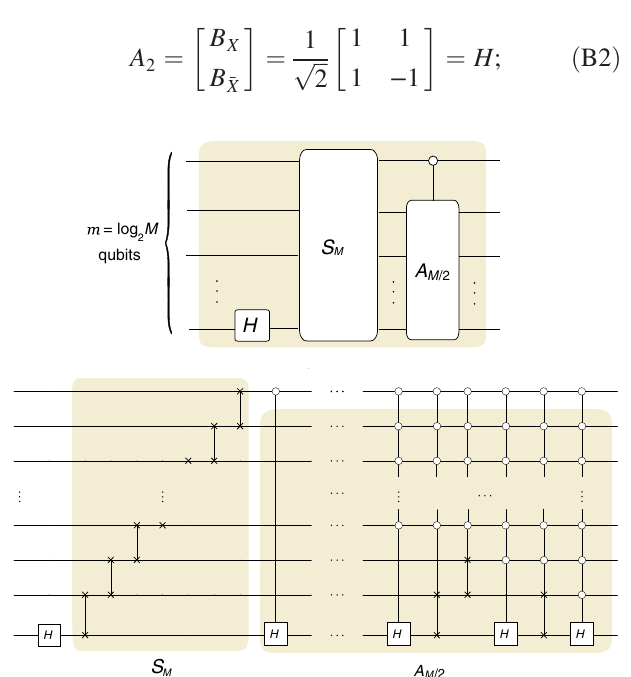
FIG. 8. Quantum circuit for the Haar wavelet transform A is a Hadamard gate, and A 2 ¼ H for the case M ¼ 2 . S